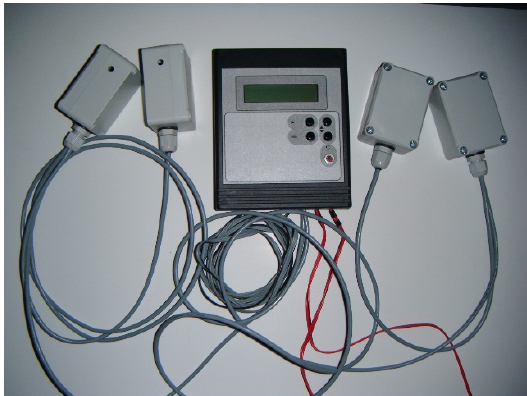
Figure 10. A device controlling a mobile dressing machine placed on planters [29].